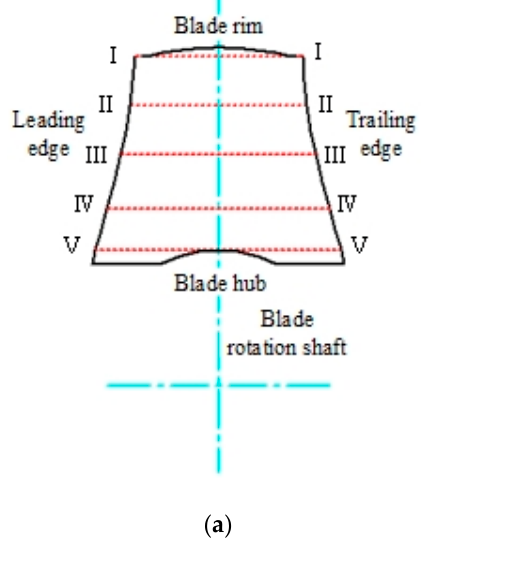
Figure 1. ( a ) Meridional contour and ( b ) blade profile of bidirectional axial-flow impeller.